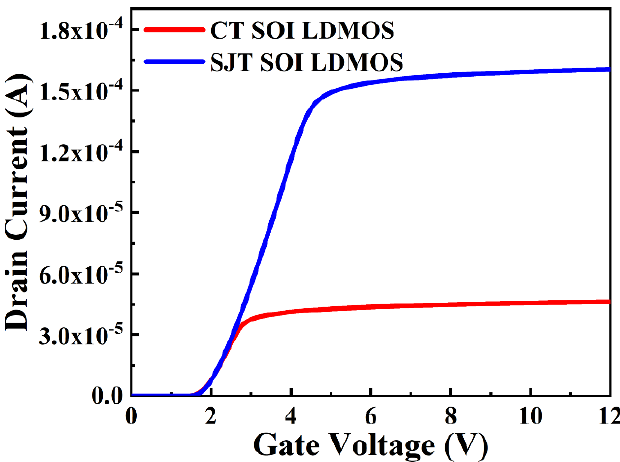
Figure 4. Transfer characteristics of the CT SOI LDMOS and SJT SOI LDMOS.